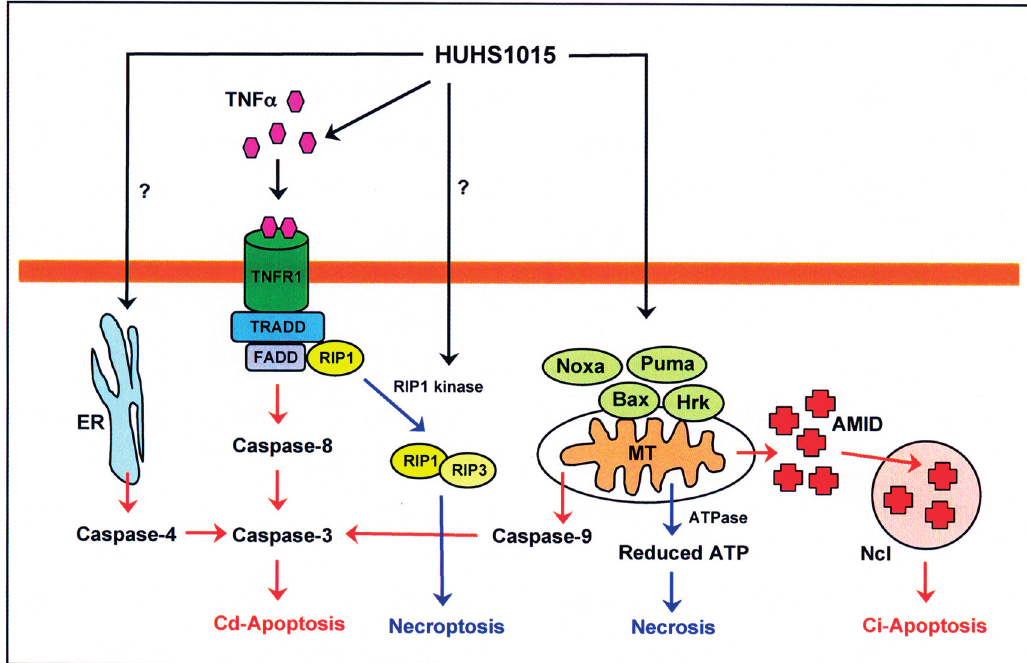
Figure 4. Schematic pathways for HUHS1015-induced cell death. Cd-Apoptosis: caspase-dependent apoptosis; Ci-Apoptosis: caspase-independent apoptosis; ER: endoplasmic reticulum; MT: mitochondria; Ncl: